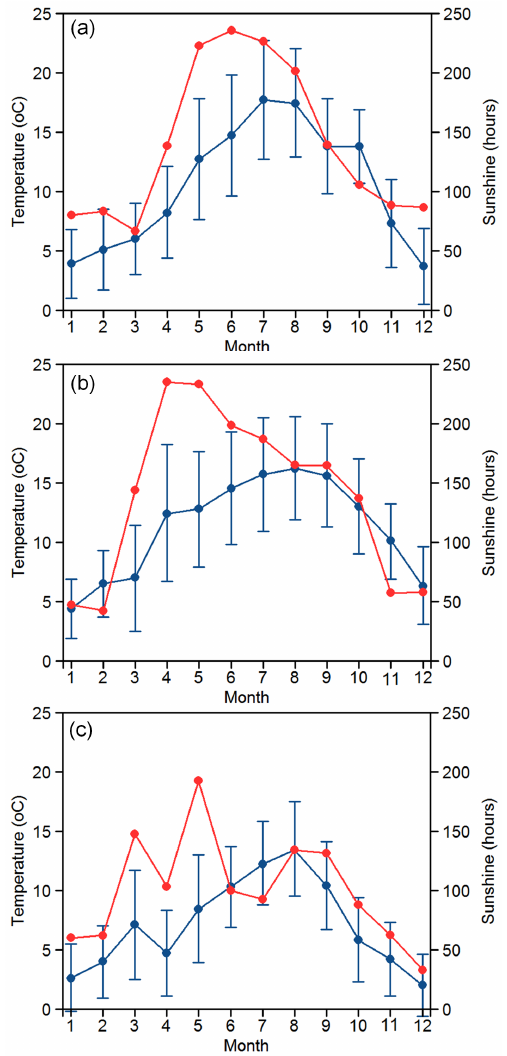
Figure 9. Average monthly mean temperatures (blue, maximum and minimum temperatures shown as whiskers) and hours of sunshine (red) from the UK Meteorological Office (http://www.metoffice. gov.uk/climate/uk/datasets/#) for (a) South East and Central South England 2001, (b) South East and Central South England 2011 and (c) East Scotland